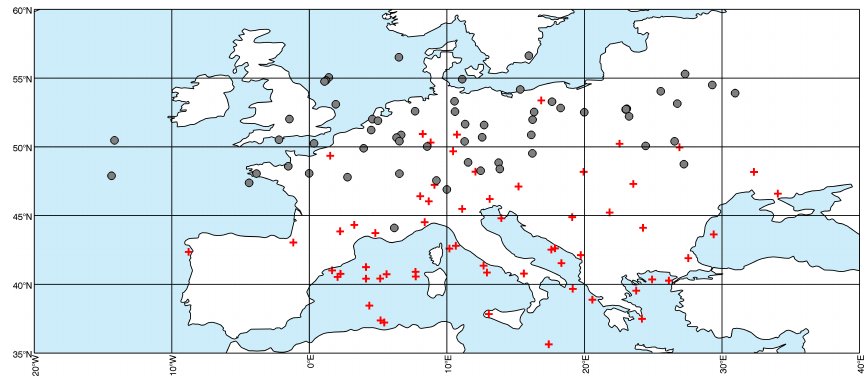
Figure 3. Locations of lightning (red crosses) and the associated satellite coordinates corresponding to the detection of LEPs (grey